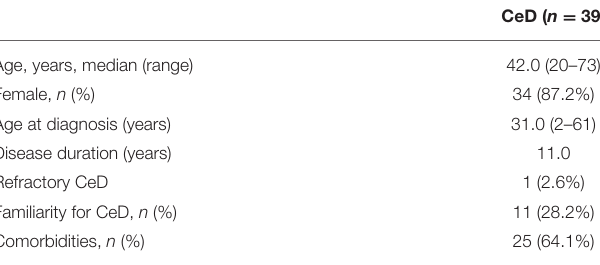
TABLE 1 | Clinical and demographic characteristics of celiac patients who accepted the televisit.